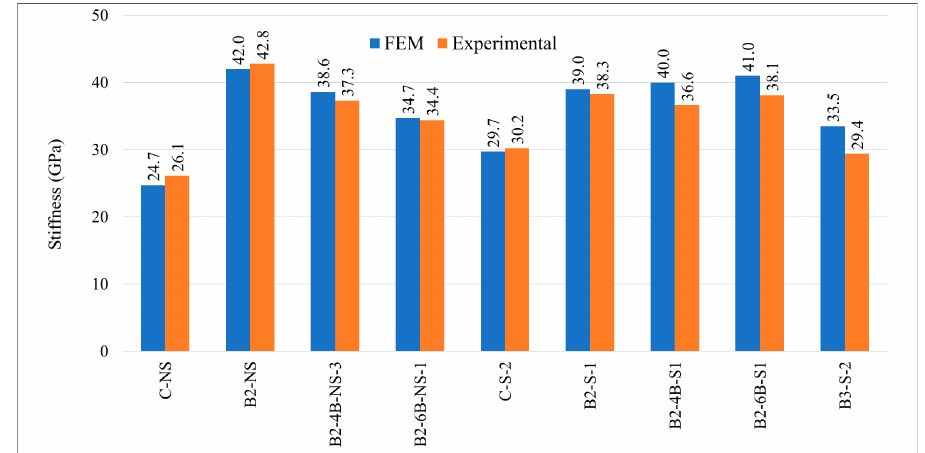
Figure 26. Comparison of beam stiffness under quasi-static loading: FEM vs. experimental results.